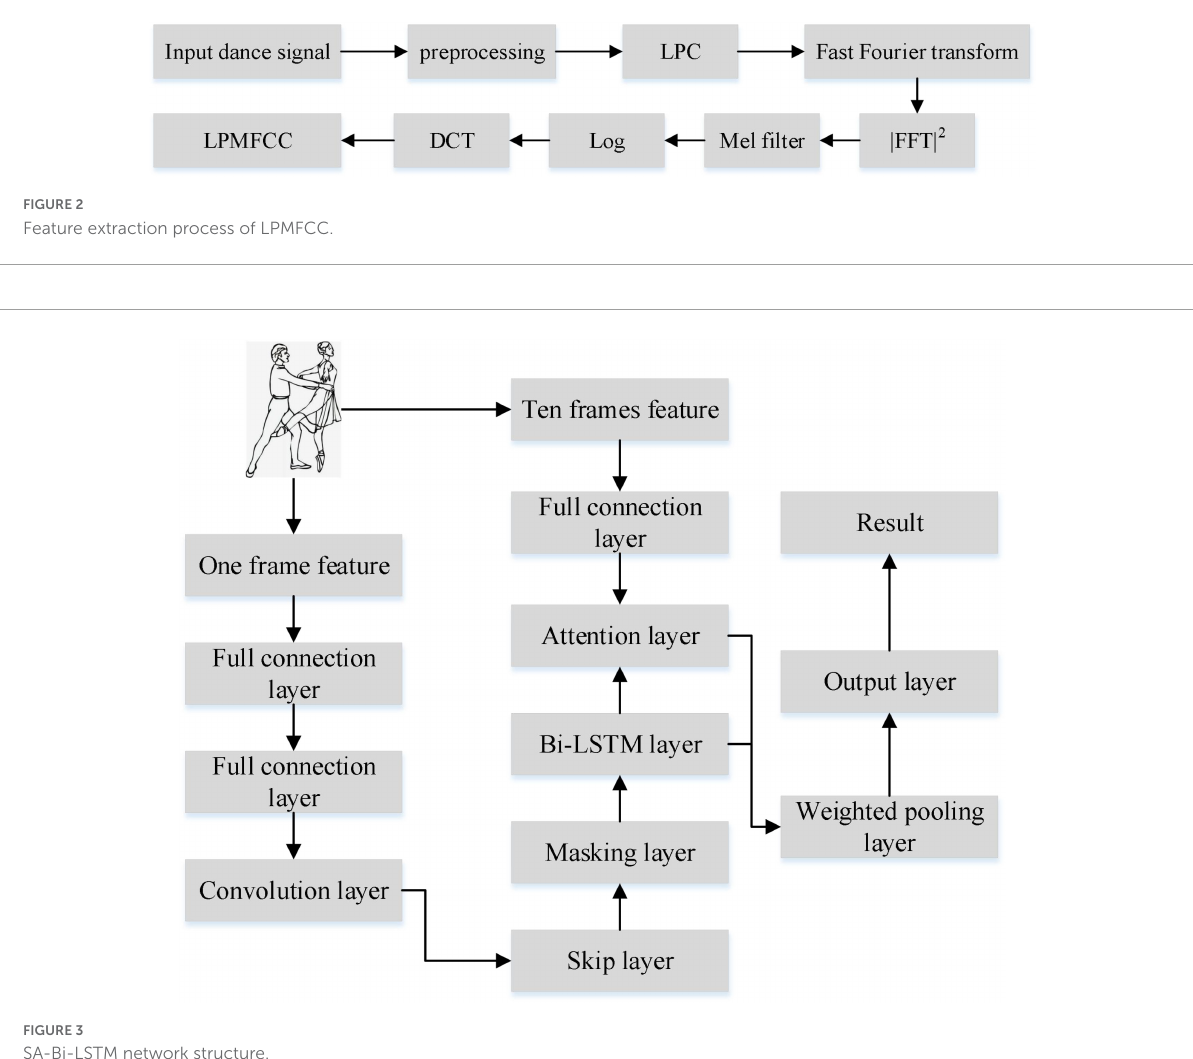
FIGURE3 SA-Bi-LSTM network